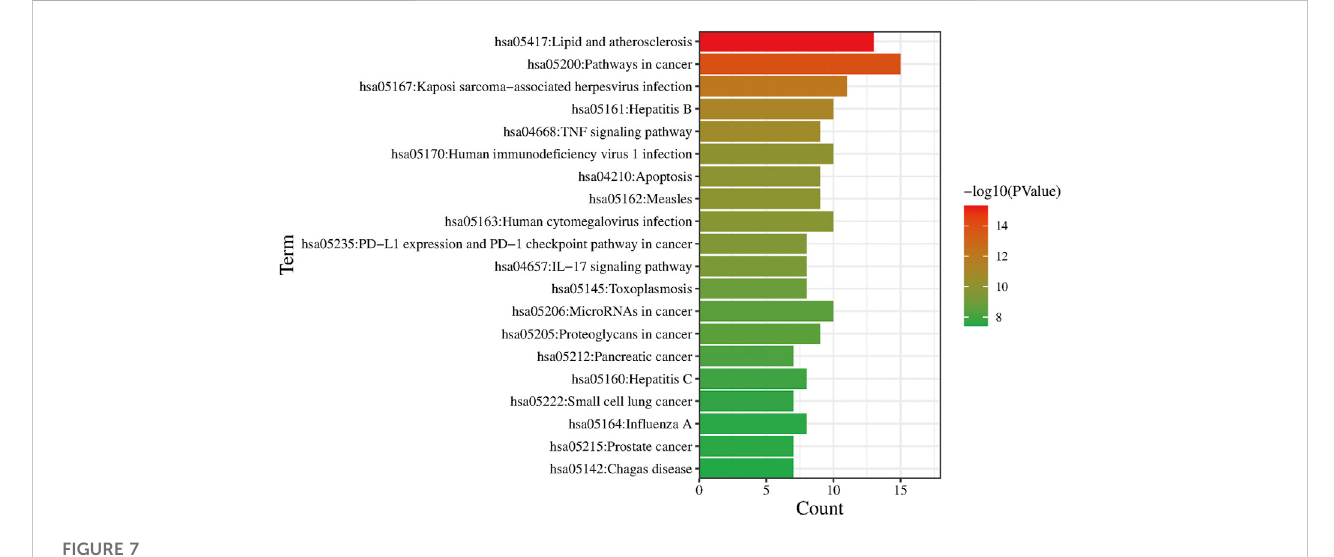
FIGURE 7 KEGG pathway enrichment